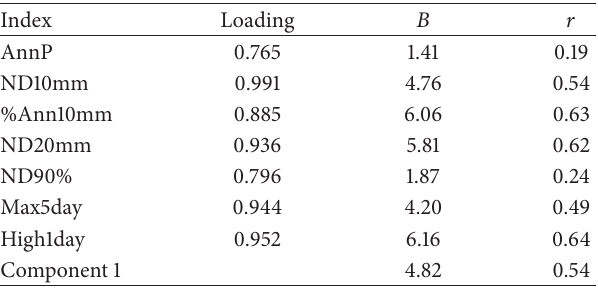
Table 3: Principal component loadings and trend results for extreme precipitation indices.